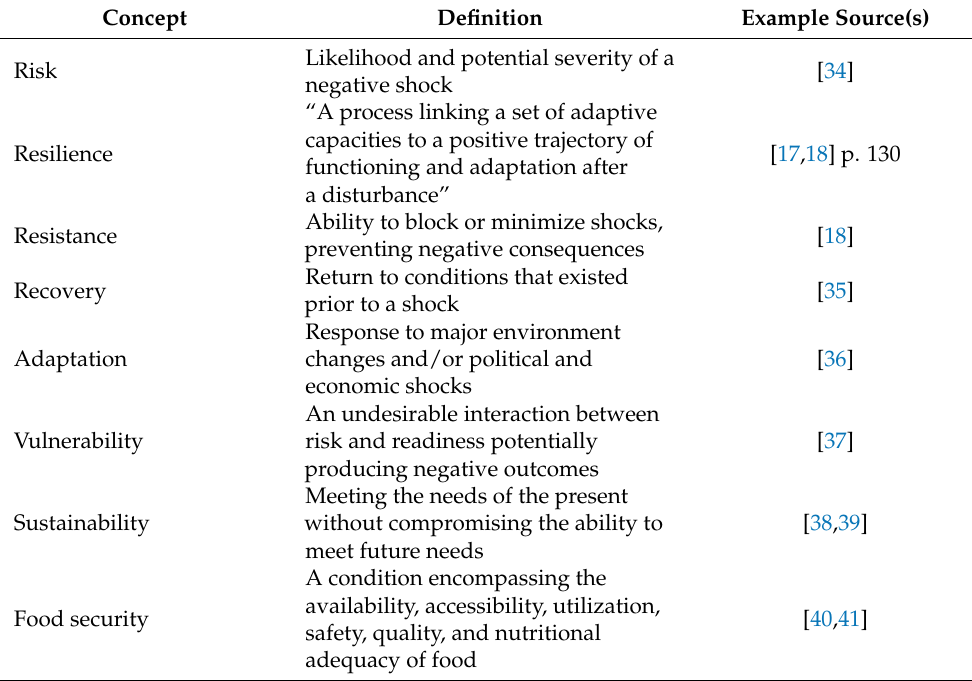
Table 1. Definitions for Figure 1